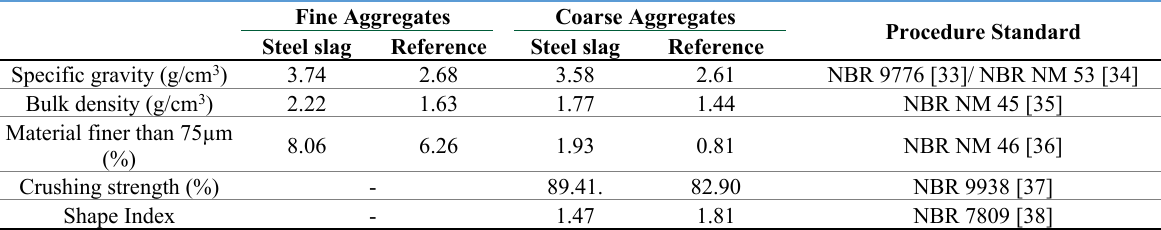
Table 2. Physical characterization of steel slag and reference aggregates